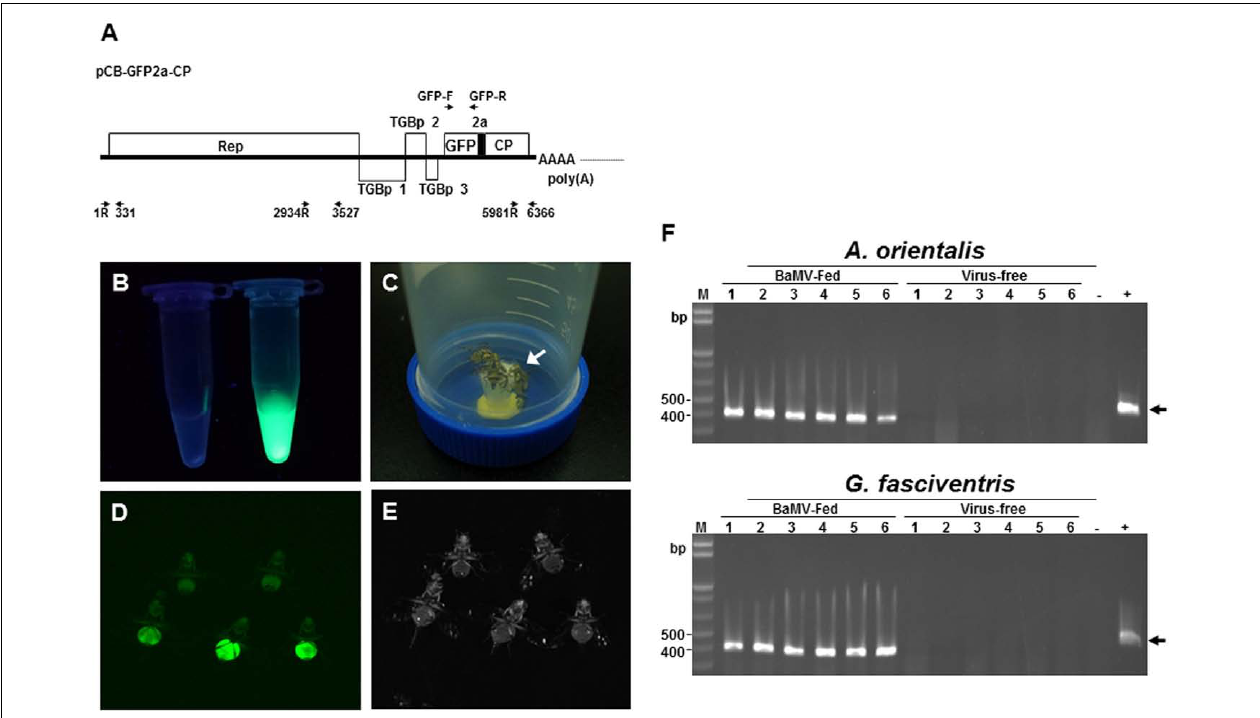
FIGURE 3 | Tracking the ingestion of BaMV in G. fasciventris . (A) Schematic representation of the plasmid pCB-GFP2a-CP. The coding sequences of FMDV 2A co-translational dissociation peptide (short black box) and GFP inserted at N-terminus of BaMV CP genes. The genome of BaMV is represented by the thick black line. ORFs were shown as boxes with identities indicated. The relative positions and directions of the primers used in Figure 5 are also shown. (B) Purified GFP-tagged BaMV particles (1 mg/ml, tube on the right) under UV illumination (360–390 nm). Equal volume of the wild type BaMV was shown on the left. (C) Virus-feeding treatment. Groups of two to seven G. fasciventris flies were fed with media containing GFP-tagged BaMV through the cotton matrix (indicated by the arrow) affixed to the cap of the tube. (D,E) Examination of the ingestion of GFP-tagged BaMV in G. fasciventris. The flies were fed with liquid medium supplemented with wild type BaMV (two flies in the upper row) or GFP-tagged BaMV (three flies in the lower row) for 24 h, anesthetized by acetone vapor, and examined by illumination of blue light (485 nm, D ) or white light (E) . Note that the flies were only slightly anesthetized by acetone for imaging to retain their ability